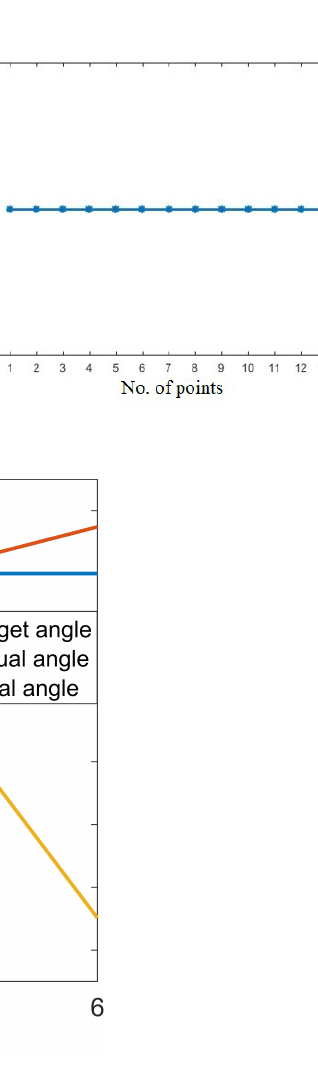
Figure 9. Experimental result on the flat